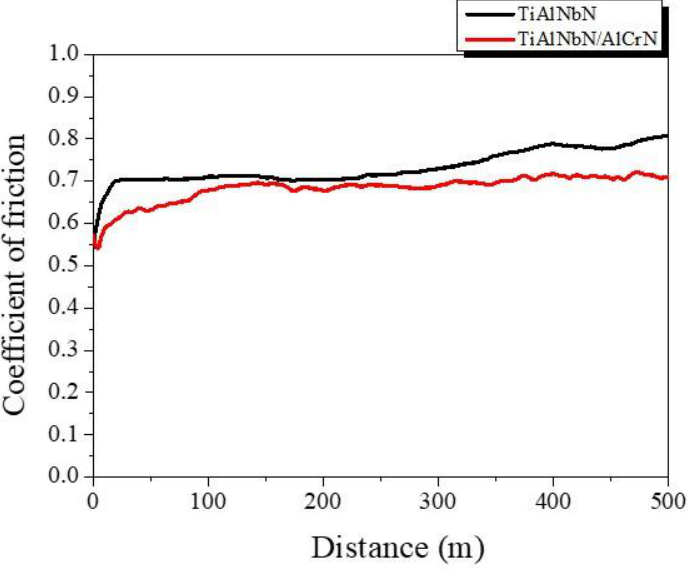
Figure 7. The coefficient of friction of the deposited TiAlNbN and multilayered TiAlNbN/AlCrN coatings on cemented carbide (WC- 8 wt.% Co) samples against cemented carbide balls as a function of sliding distance in the dry environment.